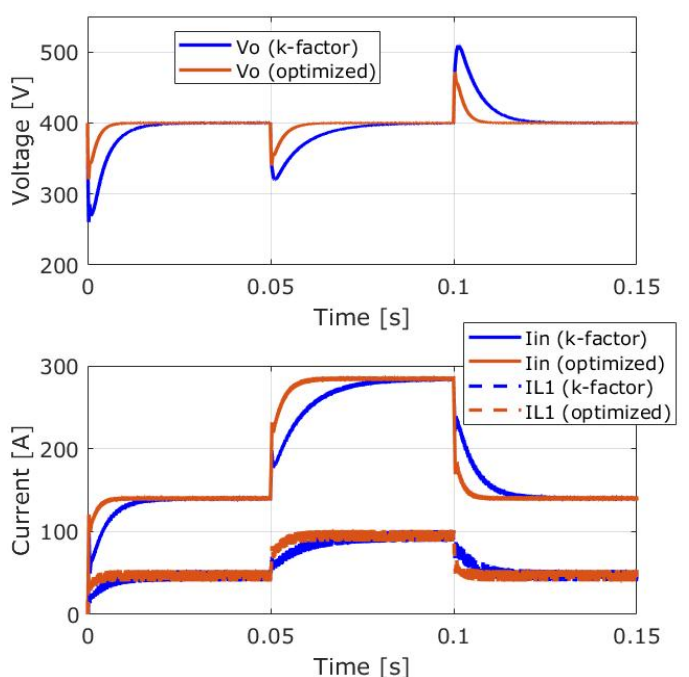
the settling time for the optimized controller can be reduced from 25 ms to 10 ms.